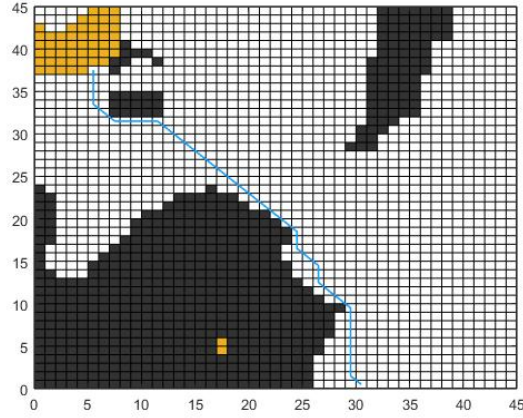
Figure 9. The result of the contrast experiment. Table 3. Comparison of the IMACO algorithm with the SACO algorithm for 4 examples.